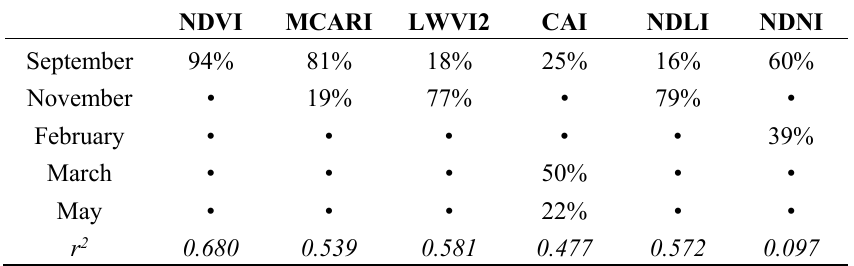
Table 5. Mean performances of the single-index models (r 2 ) and ranking of acquisition dates, according to their contributions in the BRT models. Variables not significantly selected by the models have no importance